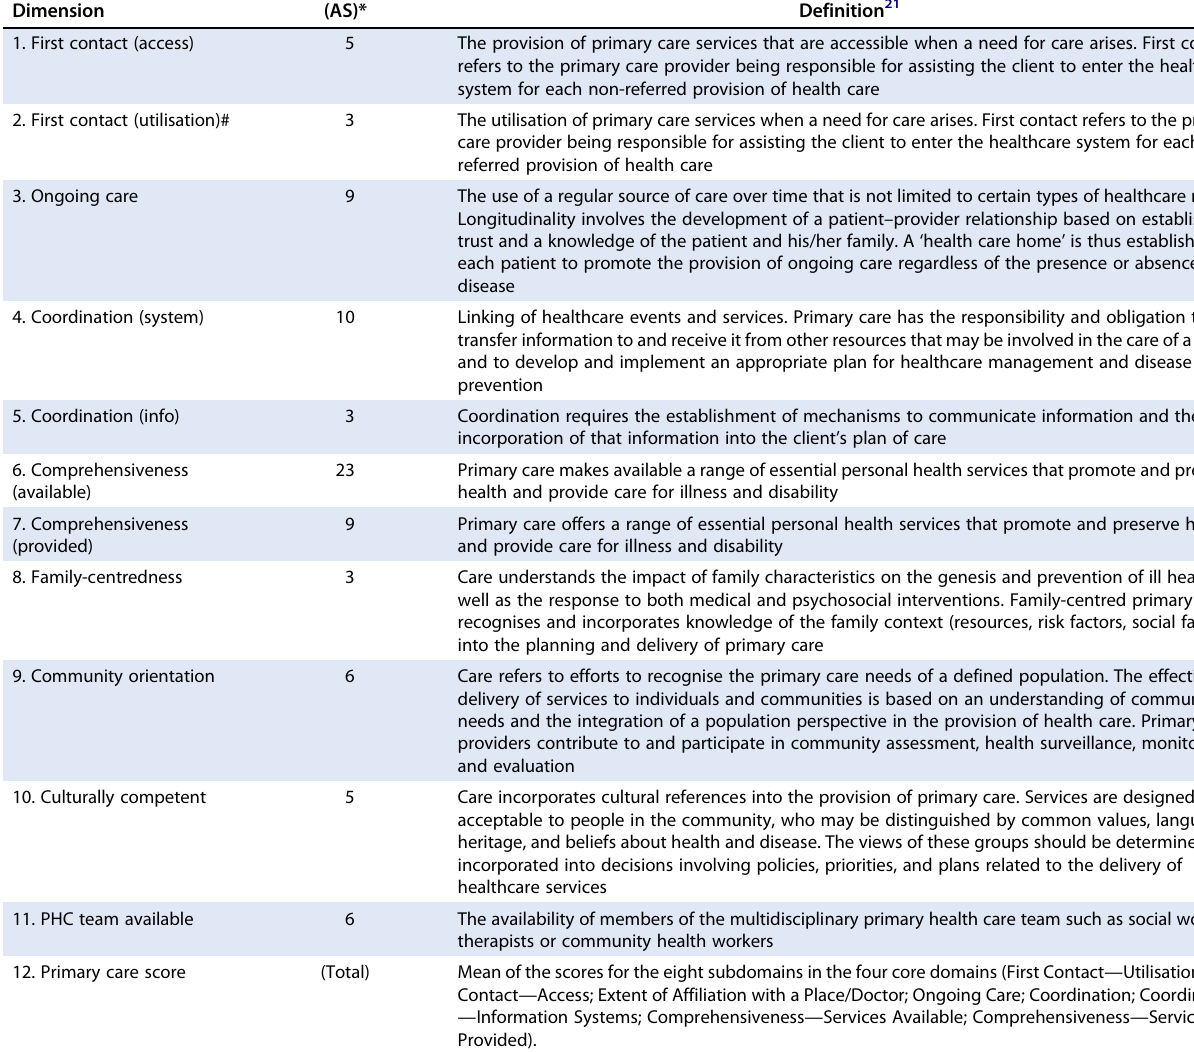
Table 1: Dimensions, items and definitions for the PCAT